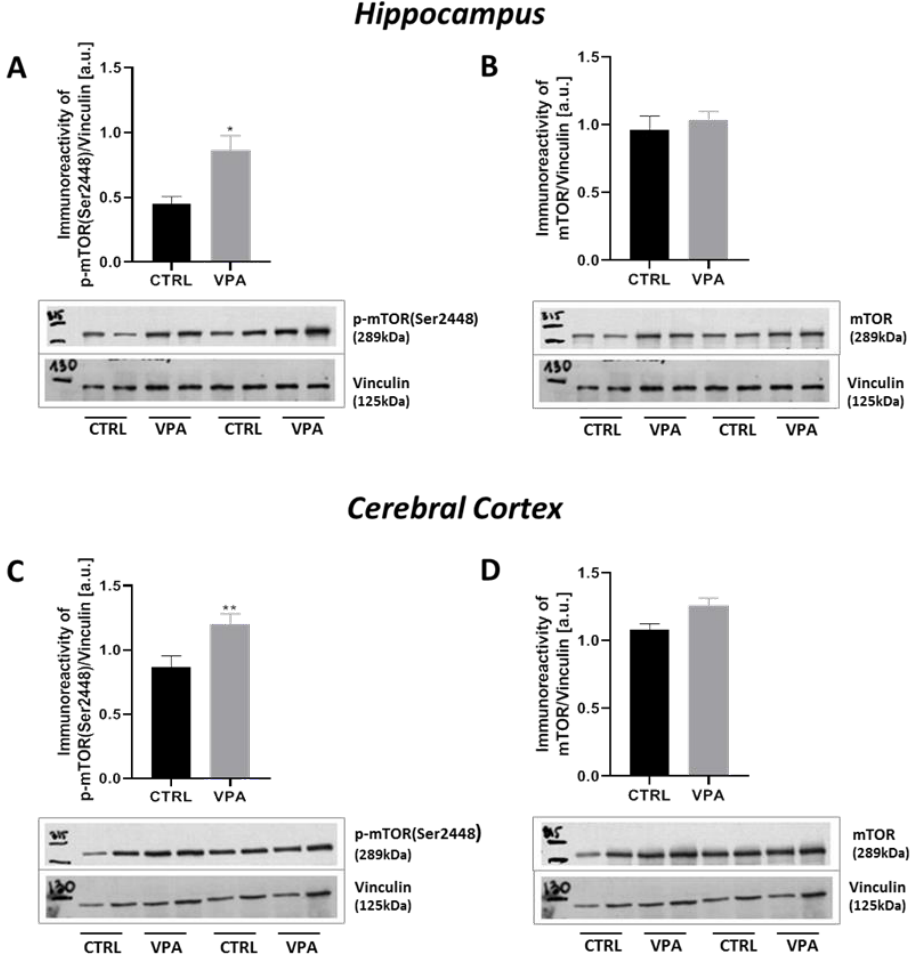
Figure 14. The effect of prenatal exposure to VPA on the mTOR in the rat brain. Immunoreactivity of phospho- mTOR(Ser2448) and total mTOR were determined using Western blot analysis. Densitometric analysis and representative pictures of phospho-mTOR(Ser2448) and mTOR in the hippocampus ( A , B ) and cerebral cortex ( C , D ) were shown. Results were normalized to Vinculin levels. Data represent the means ± S.E.M. from n = (4) independent experiments in the hippocampus: ( A ) n = 4 (CTRL), n = 4 (VPA); ( B ) n = 4 (CTRL), n = 4 (VPA); and n = (5) in the cerebral cortex: ( C ) n = 5 (CTRL), n = 5 (VPA); ( D ) n = 5 (CTRL), n = 5 (VPA). * p < 0.5, ** p < 0.01, vs.